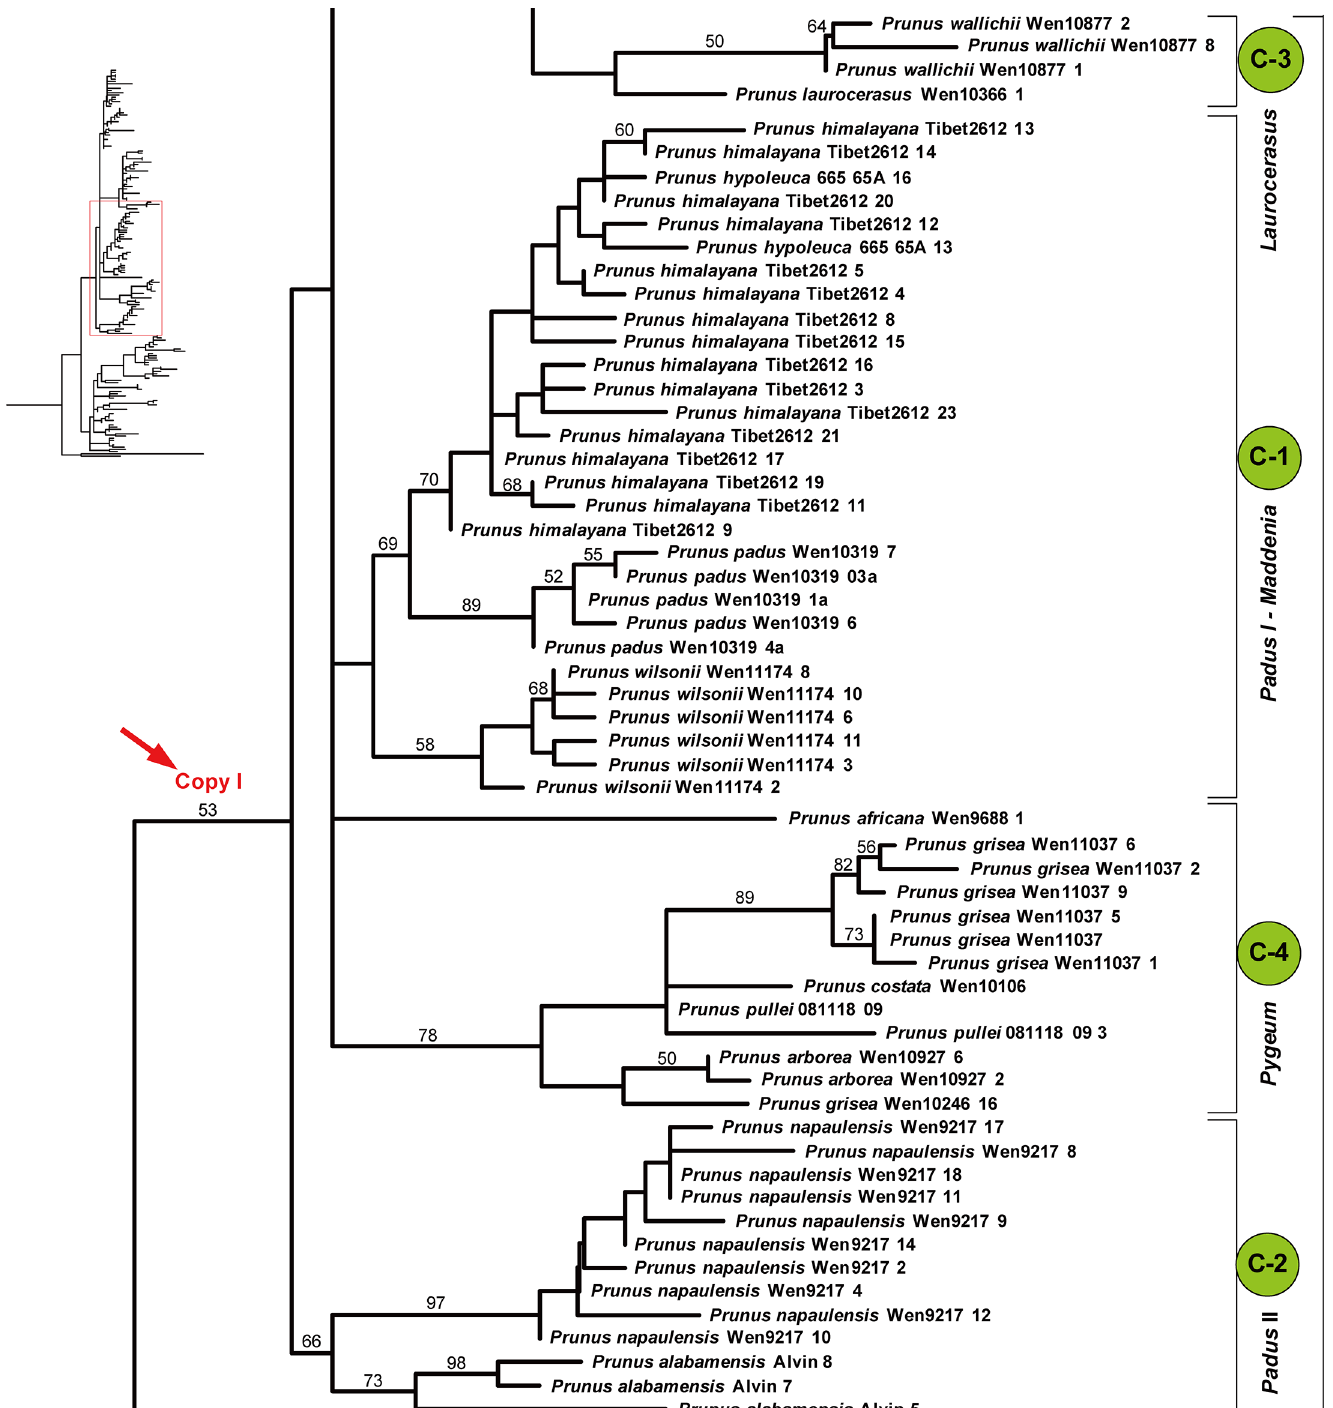
Fig 3. Maximum likelihood (ML) tree inferred from the At103 DNA sequences of Prunus . The results of ML bootstrap analysis are shown above the branches. Bootstrap values > 50% are shown.